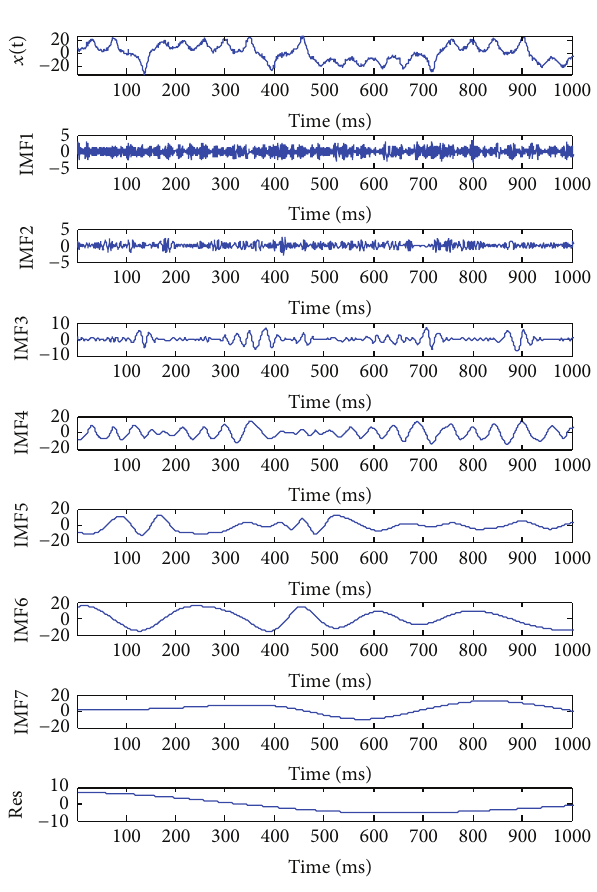
Figure 4: EEMD results of Lorenz signal.